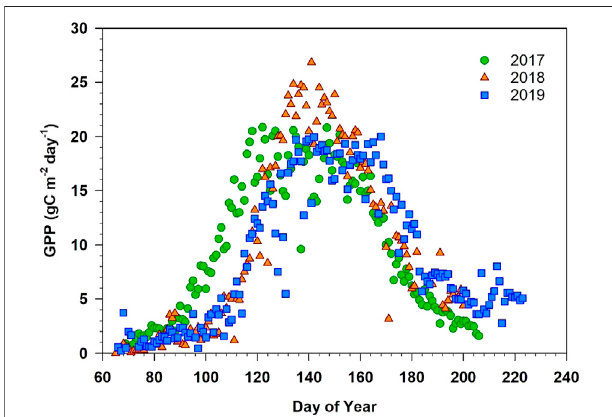
FIGURE 3 | Daily gross primary production (GPP) of maize during the 2017, 2018, and 2019 growing seasons.